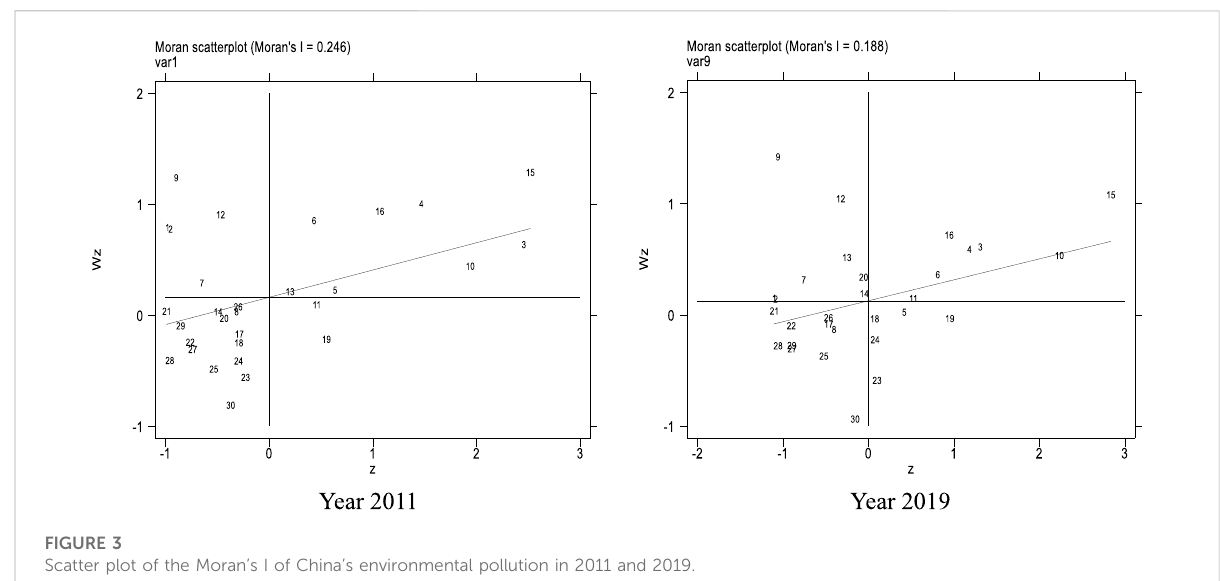
FIGURE 3 Scatter plot of the Moran ’ s I of China ’ s environmental pollution in 2011 and 2019.